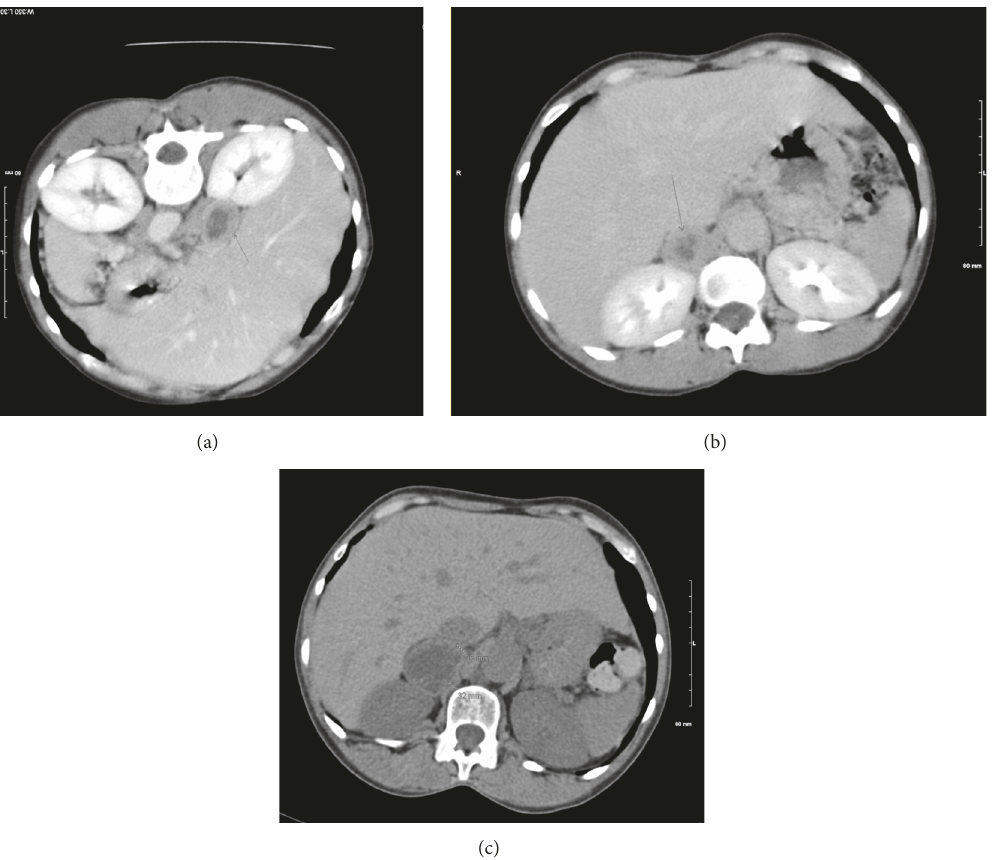
Figure 2: (a-b) CT abdomen and pelvis with contrast in 2006 demonstrating a large right adrenal mass with a hypodense center (a) venous phase and (b) delayed imaging. (c) Noncontrast CT abdomen pelvis in 2013 showing interval increase in size of the right adrenal mass to 3.7 x 3.2 cm from 2.3 x 1.9